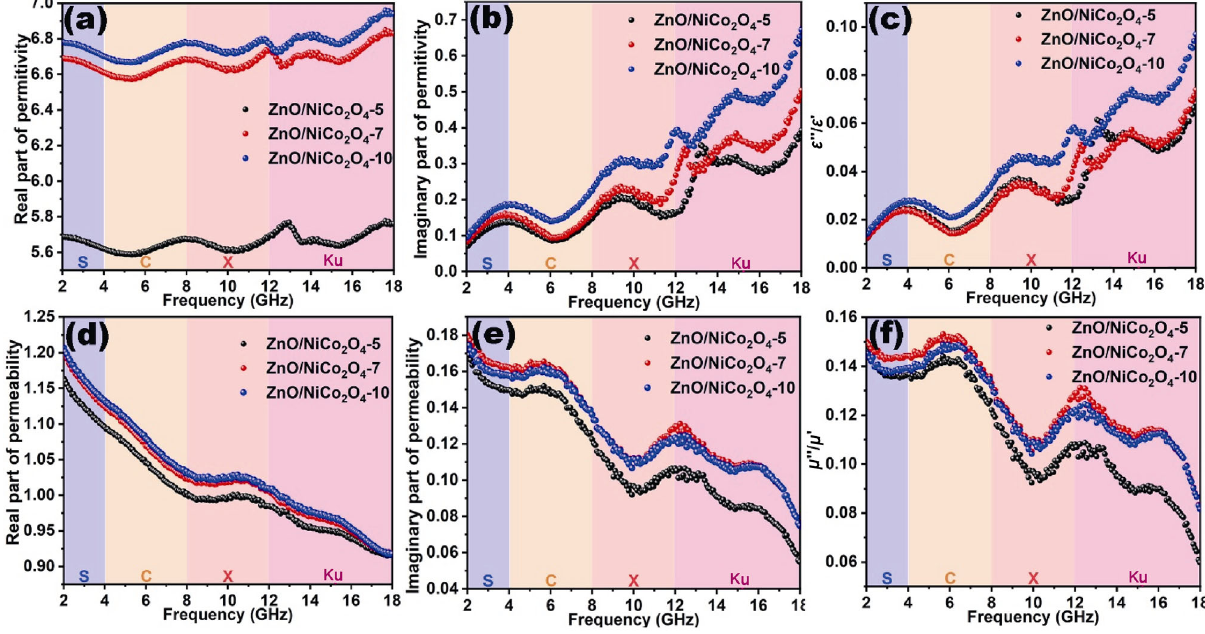
Fig. 5 Electromagnetic parameters of the ZnO/NiCo 2 O 4 range of 2.0–18.0 GHz: (a) real parts of permittivity ( ε ' ); (b) imaginary parts of permittivity ( ε '' ); (c) ε '' / ε ' ; (d) real parts of permeability ( μ ' ); (e) imaginary parts of permeability ( μ '' ); and (f) μ '' / μ '